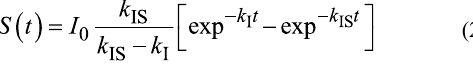
tion occurs via heteronuclear dipolar interaction between the two spin species ( I–S ) when the Hartmann–Hahn condition is met. In the present work only 1 H, 13 C magnetization transfer